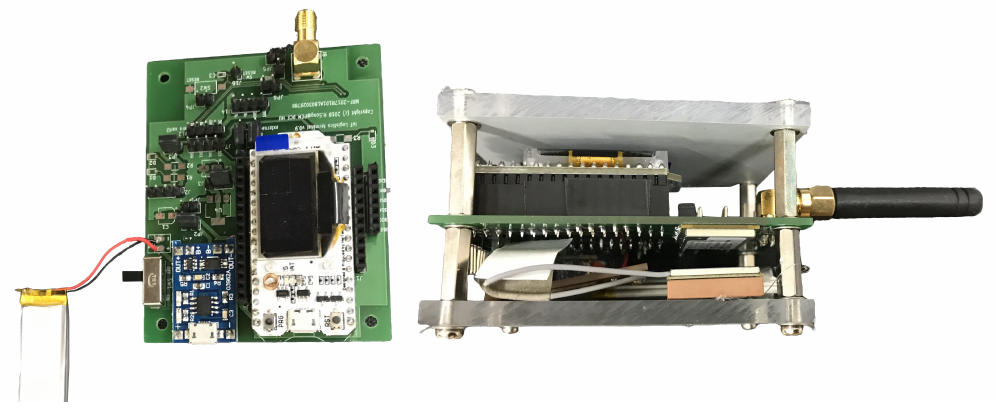
Figure 6. Image of the IoT device